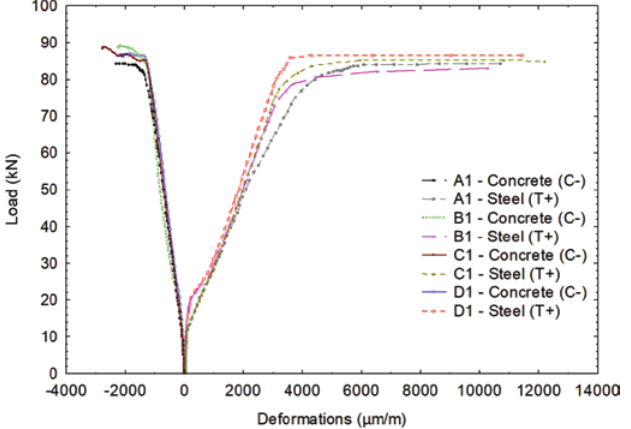
Specific deformations of steel and concrete